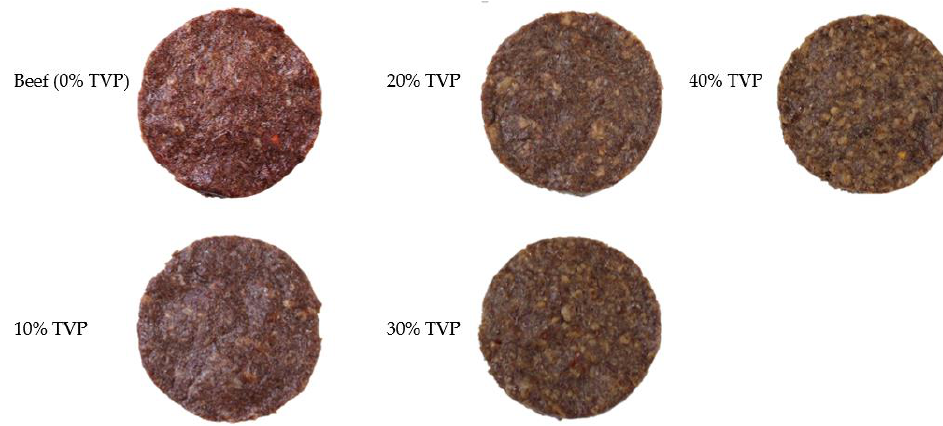
Figure 2. Typical beef patties with different levels of TVP substituted.